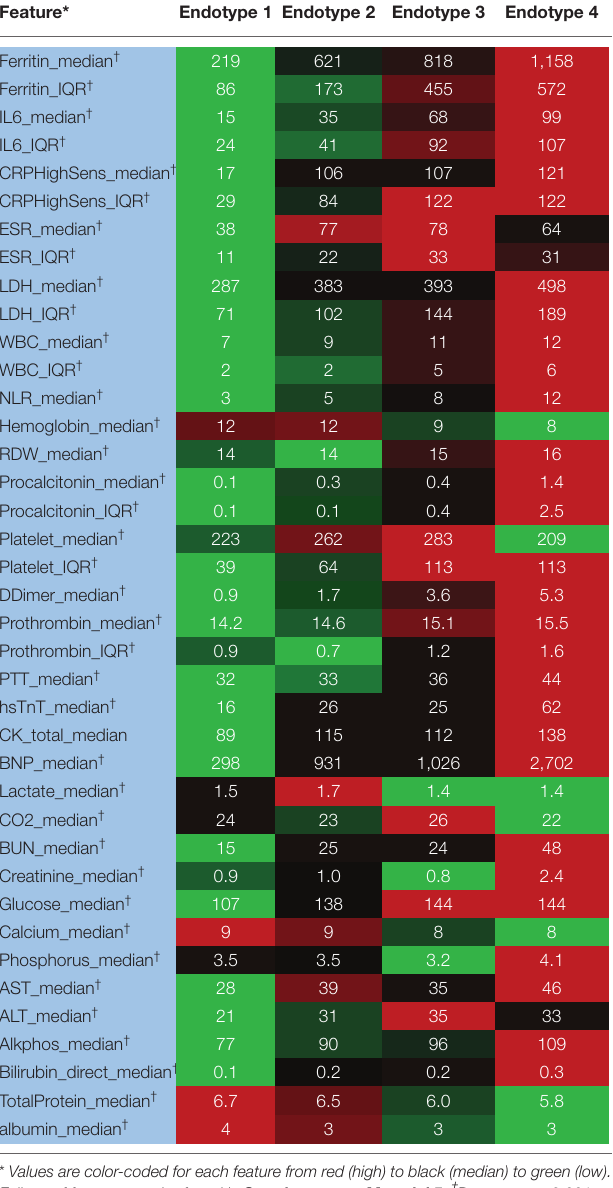
Frontiers in Medicine |